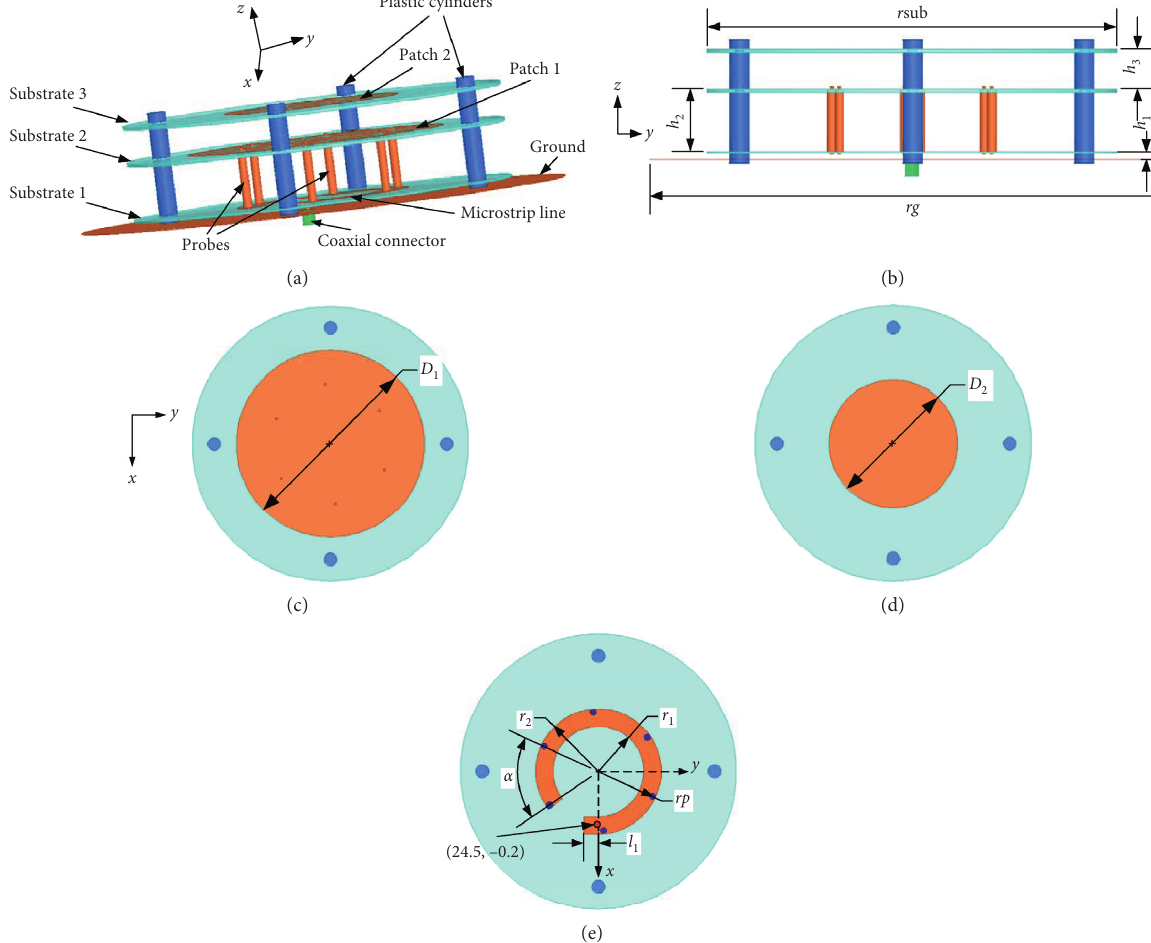
Figure 1: Geometry of the proposed antenna. (a) 3D view, (b) side view, (c) patch 1, (d) patch 2, and (e) microstrip line. Table 1: Dimensions of the proposed antenna.